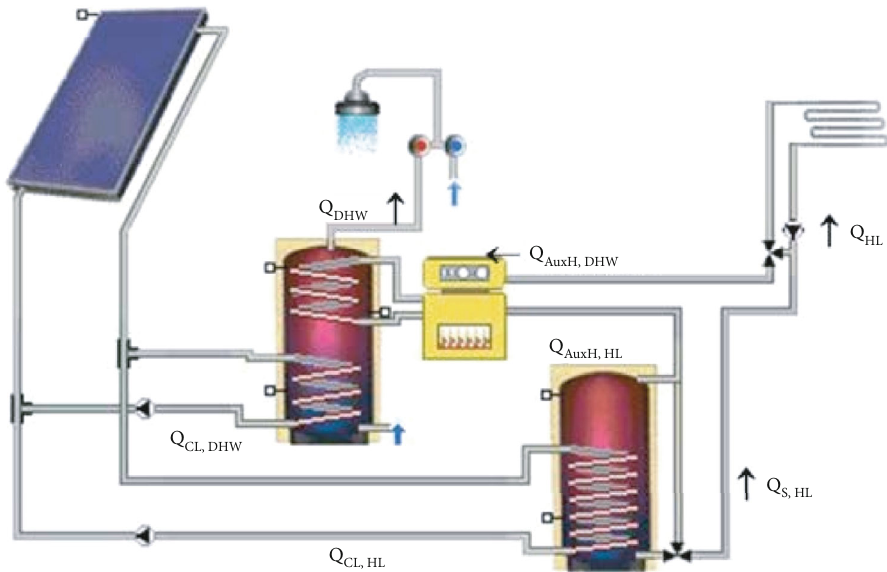
Figure 5: The location of studied cities.